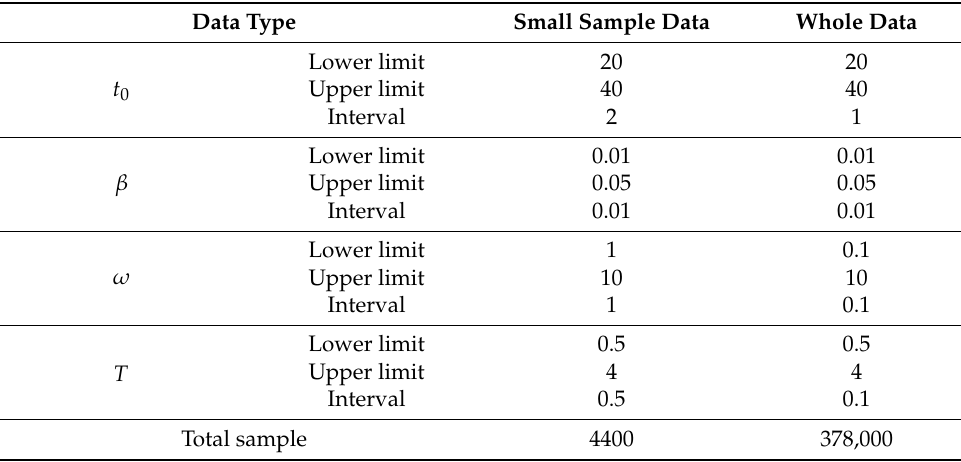
Table 2. Samples used for training and